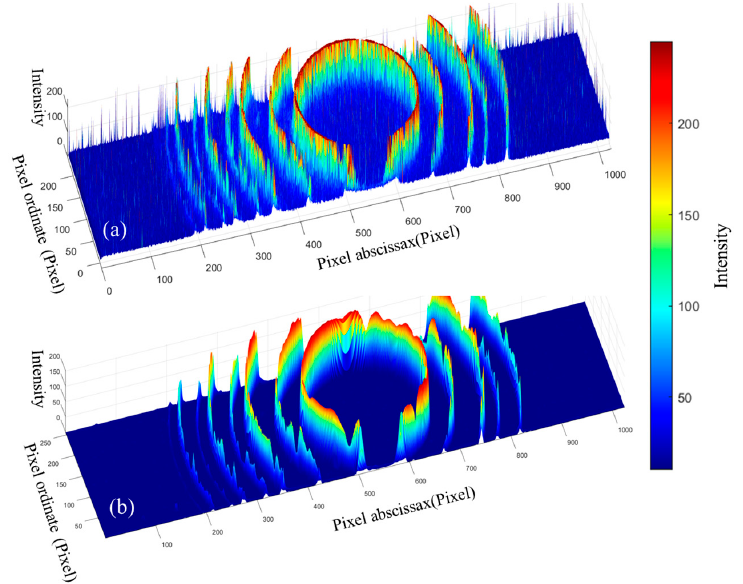
Figure 6. ( a ) Original spectrum of experimental measurement; ( b ) spectrum after noise removal using Frangi filter.